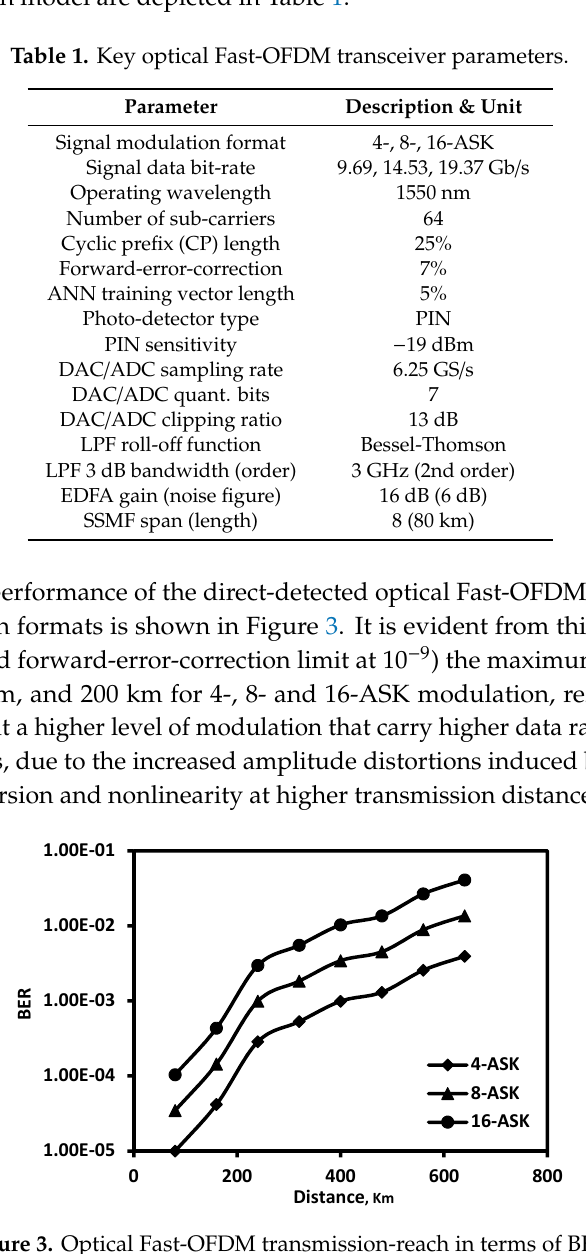
Figure 3. Optical Fast-OFDM transmission-reach in terms of BER.